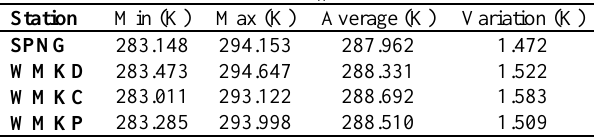
Table 3. The statistical result of T M for each radiosonde station Station